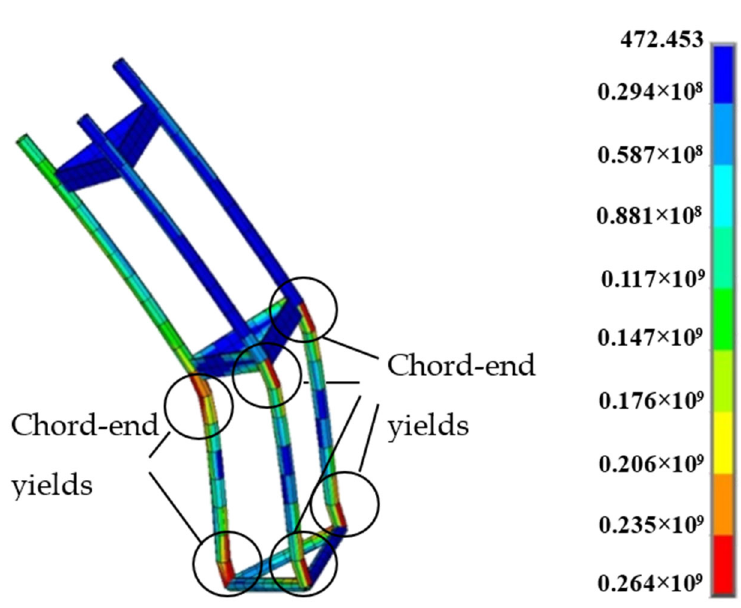
Figure 20. Chord local failure global stress distribution (Pa).